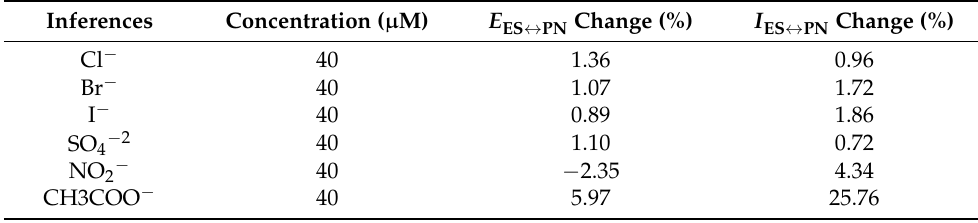
Table 2. Deviation in the ES ↔ PN redox peak by negative anions.